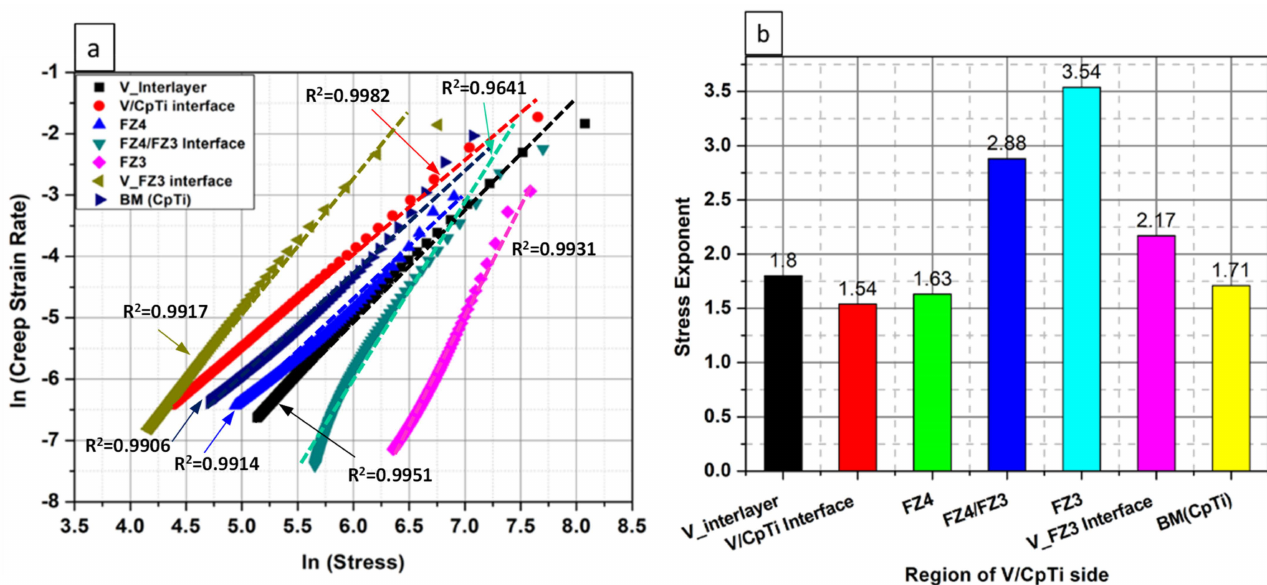
Figure 17. ( a ) ln (creep strain rate)-ln(stress) plots of different regions of V and CpTi side. ( b ) Creep stress exponent of different regions in V and the CpTi